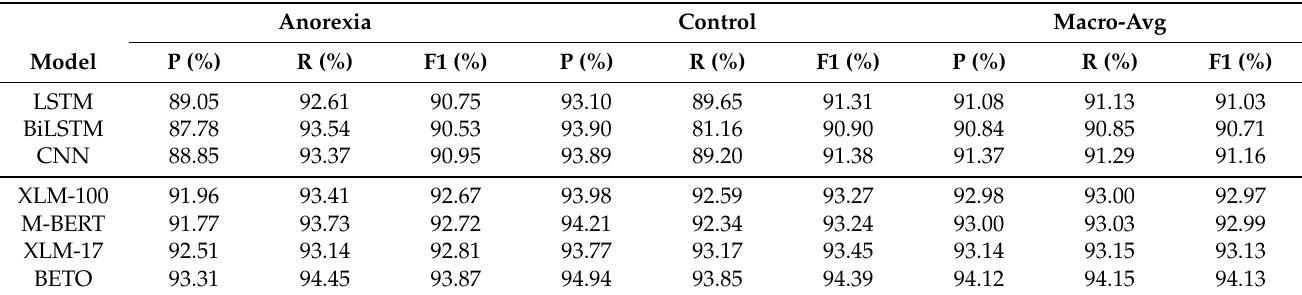
Table 2. Results obtained on the SAD